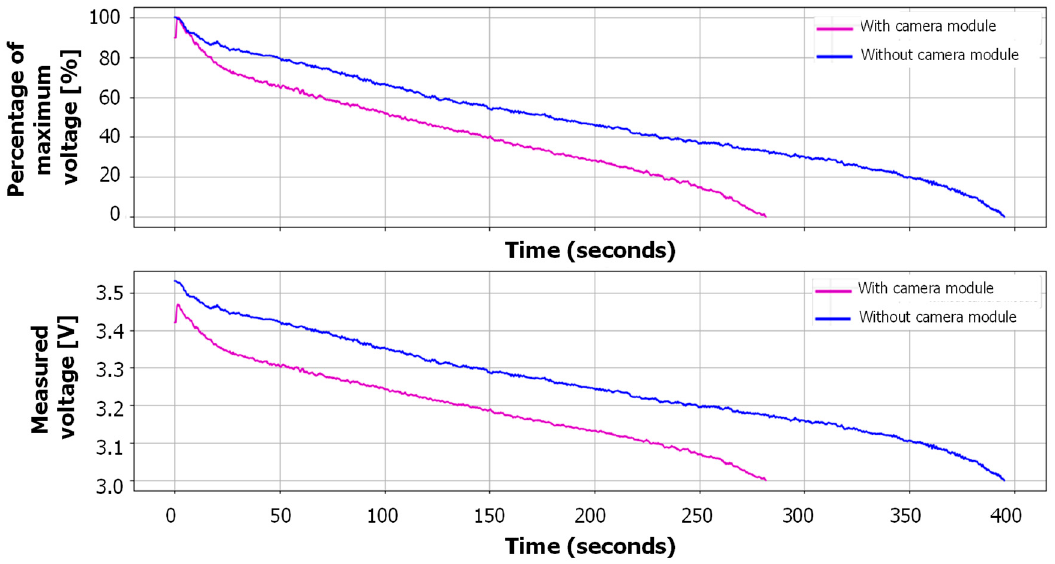
Figure 10. Changes in the effective flight time of the MAV with and without the camera